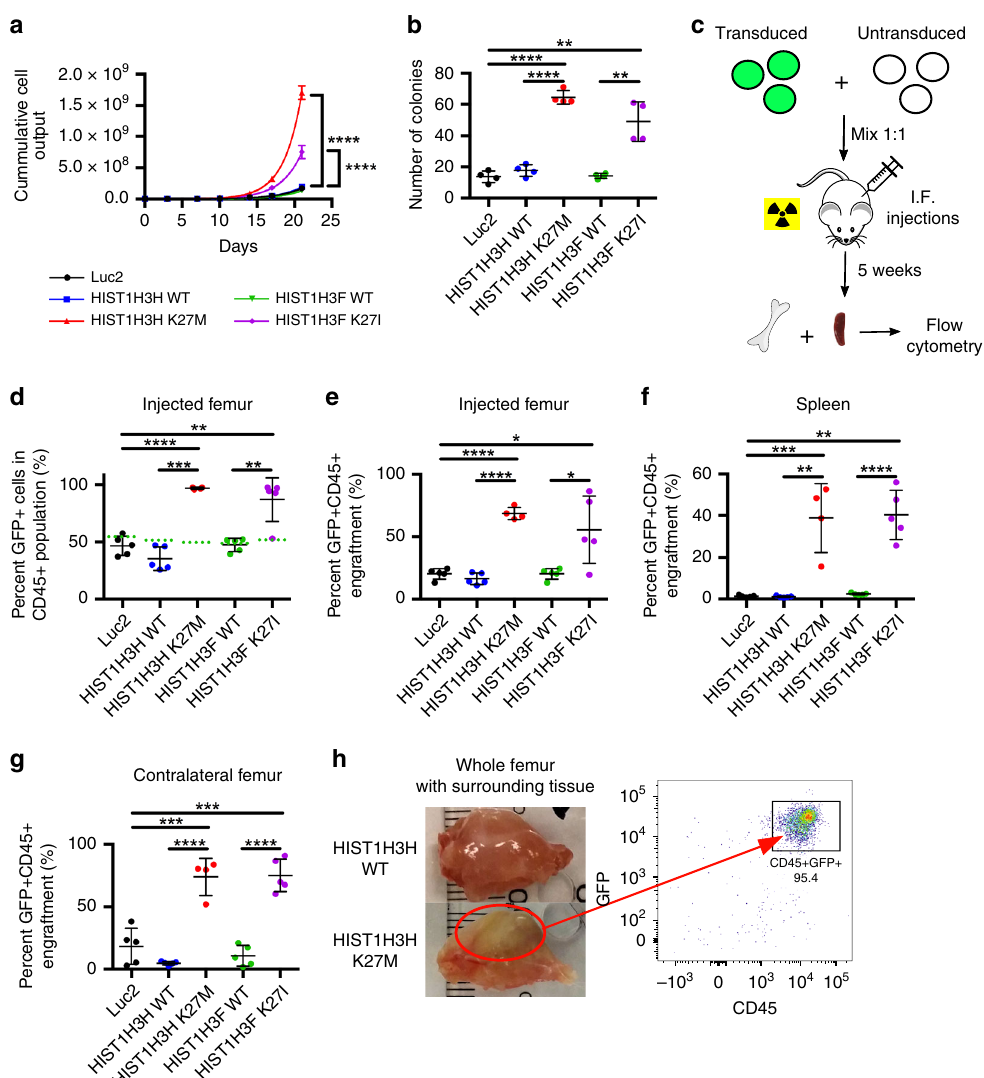
Fig. 2 H3.1 K27M/I mutations increase the proliferation of AML cells in vitro and in vivo. a In vitro cell proliferation assay of TEX cells transduced with HIST1H3H WT (blue), HIST1H3H K27M (red), HIST1H3F WT (green), HIST1H3F K27I (pink), and Luc2 control (black) ( n = 3, representative of